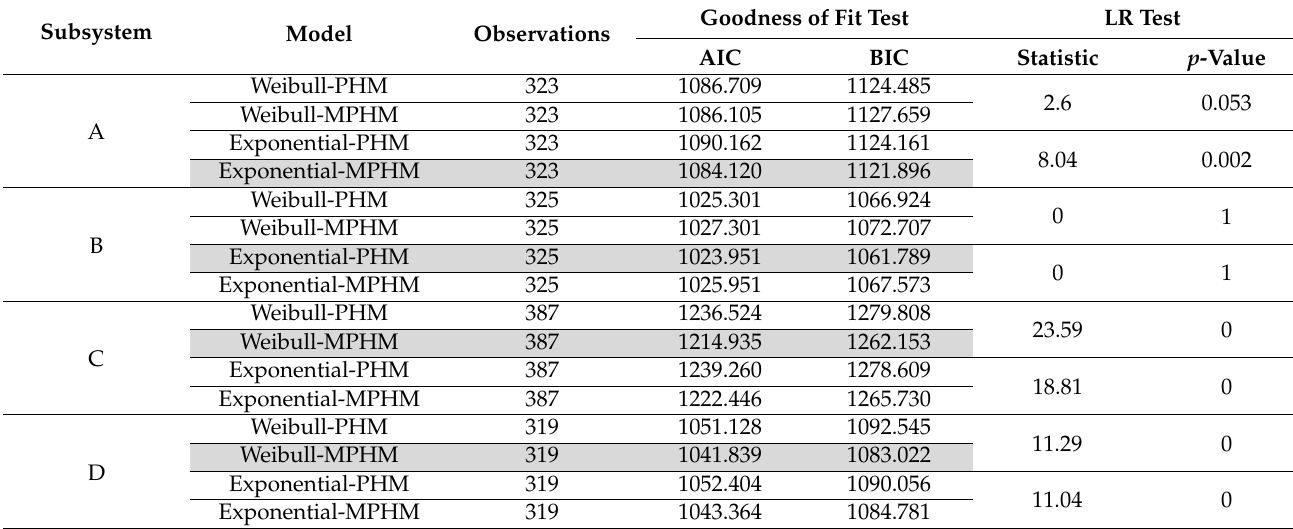
Table 4. The results of model selection for subsystems based on Akaike information criterion (AIC), Bayesian information criterion (BIC), and likelihood ratio ( LR ) test.